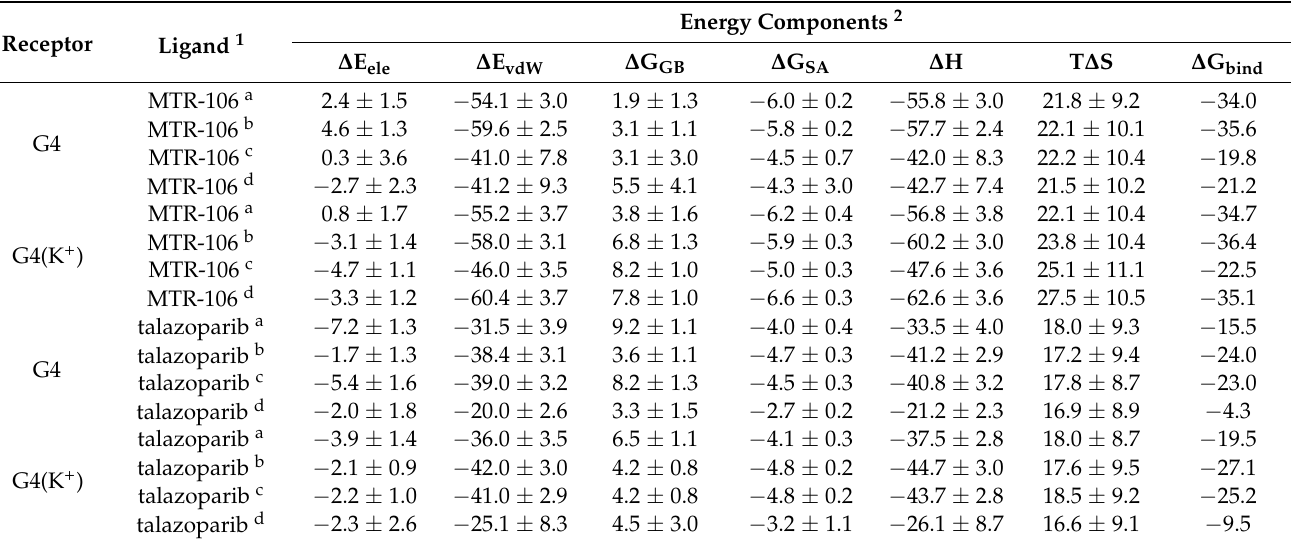
Table 3. Binding-free energies between PARP1 G4/G4(K + ) and the binding